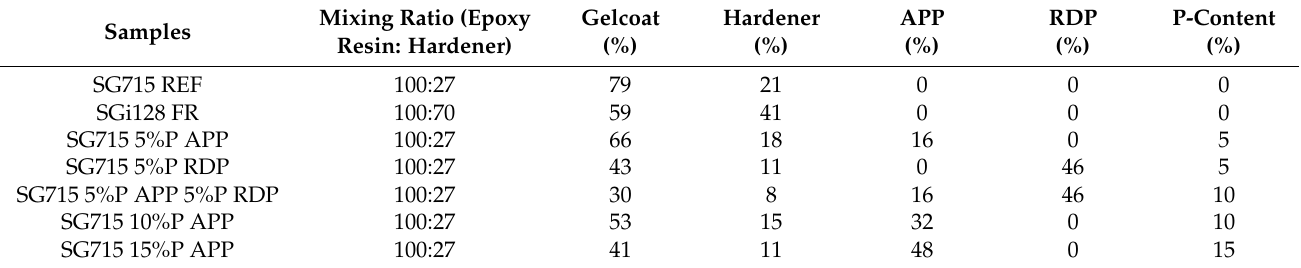
Table 1. The reference and flame retardant gelcoat formulations.